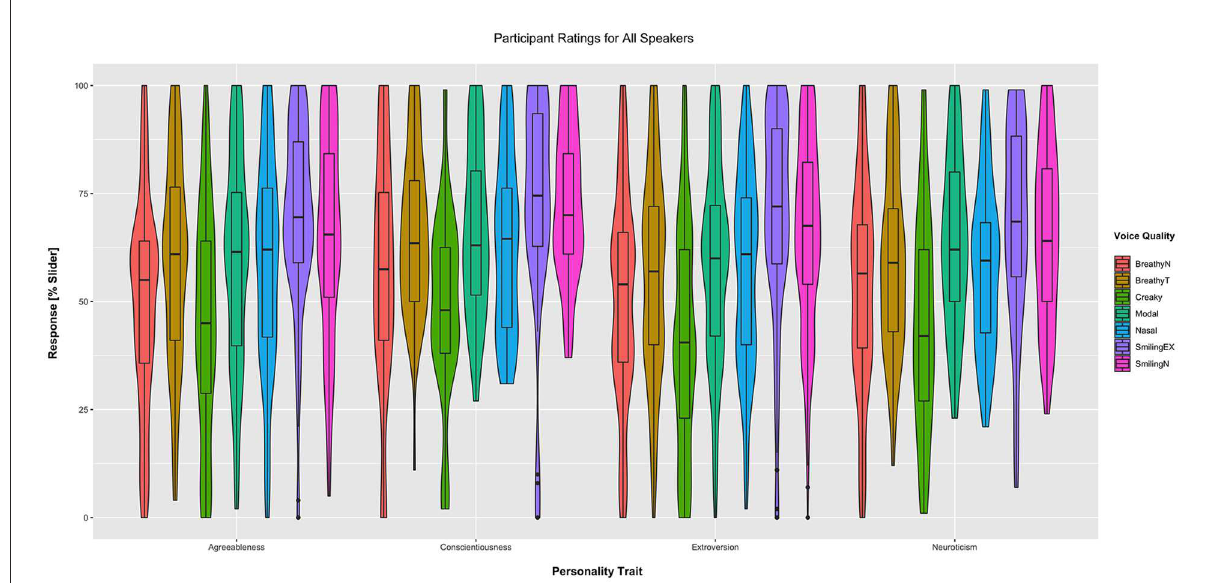
FIGURE3 Voice quality ratings for all listeners aggregated over all six speakers’ productions. The y-axis displays the slider position percentage (0% corresponding to the left extreme value of the slider and 100% to the opposite extreme). The x-axis shows the aggregation of the 10 statements into the four personality traits of interest: agreeableness, conscientiousness, extroversion, and neuroticism. The colors represent the various examined vocal qualities. Shown are violin plots with overlaid